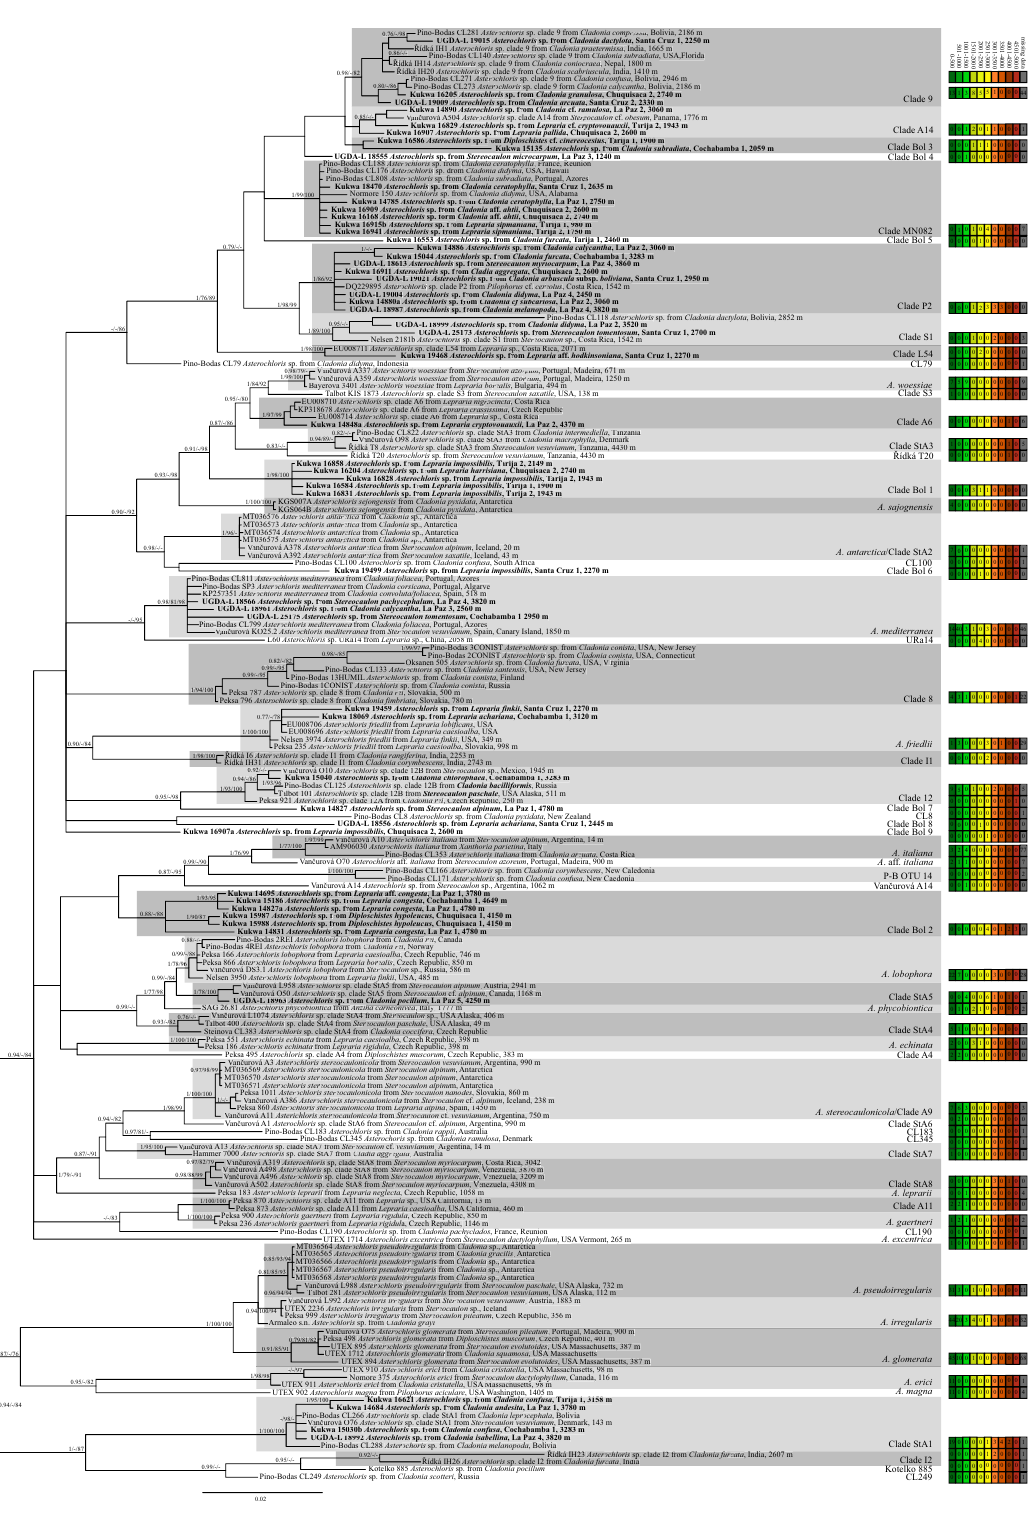
Figure 1. Majority-rule consensus tree from Bayesian analysis of Asterochloris based on ITS rDNA, rbc L and actin type I locus data set with posterior probabilities and bootstrap support values from RaxML and IQ-TREE analysis presented near the branches. For each record GenBank accession no. or voucher no. (for newly sequenced samples) are followed with photobiont name (if known), their mycobiont host name and the origin of specimen together with altitude (if known). Newly sequenced photobionts from Bolivia are marked in bold. Species or phylogenetic lineages are marked in boxes with appropriate names. Based on altitude of the samples, which belongs to particular phylogenetic lineage, we added summary of abundance for each lineage. Samples from 0 to 500 m a.s.l. are in first box, from 501 to 1000 are in second box, from 1001 to 1500 are in third box, from 1501 to 2000 are in fourth box, from 2001 to 2500 are in fifth box, from 2501 to 3000 are in sixth box, from 3001 to 3500 are in seventh box, from 3501 to 4000 are in eighth box, from 4001 to 4500 are in ninth box, from 4501 to 5000 are in tenth box and samples with missing data of altitude are in eleventh box, marked in